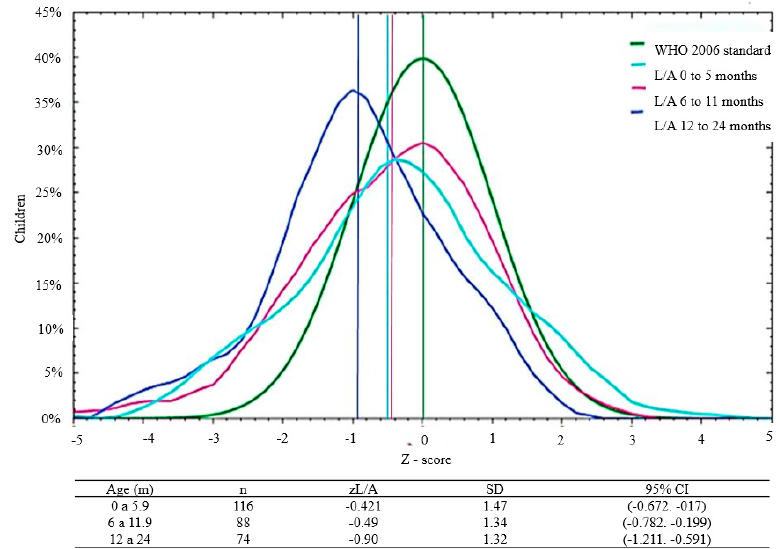
Figure 1. Distribution of L/A z -scores by sex* in 278 infants and young children seen at the Klinik Saint Espri Health Center, Port au Prince, Haiti (August 2014). Footnote: The green line indicates the WHO 2006 standard; the yellow line represents males and the red line females. * ANOVA, p = 0.029.